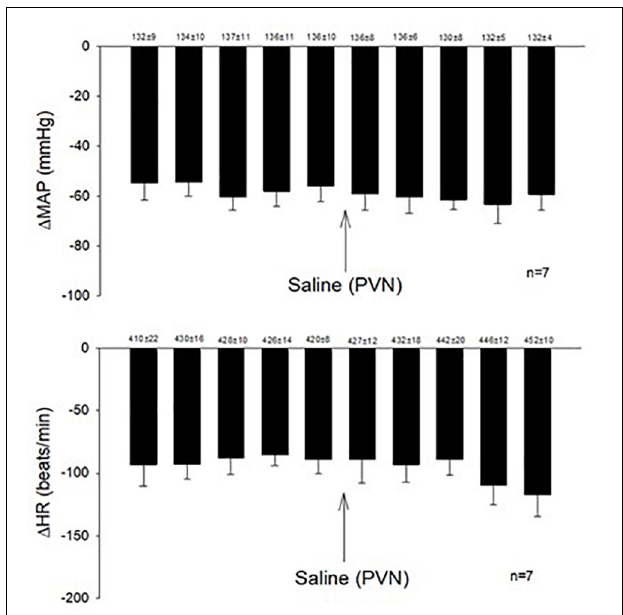
FIGURE 1 | Repeated administration of PBG induced consistent Bezold-Jarisch reflex responses. The depressors and bradycardia reflex responses were not altered after microinjection of saline into the PVN. Baselines blood pressures and heart rates in mean ± SEM shown above bars were not significantly different throughout experiments.